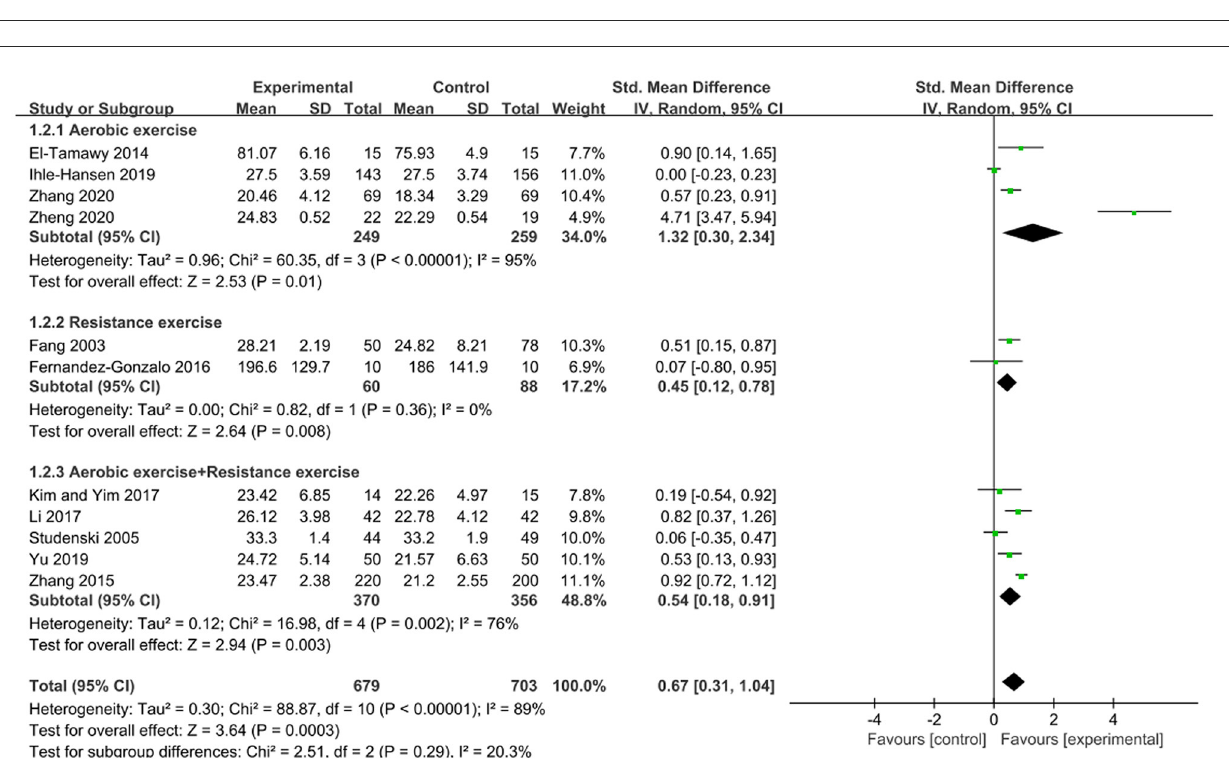
FIGURE4 Subgroup analysis of the effects of different types of exercise on cognitive function in patients with PSCI.